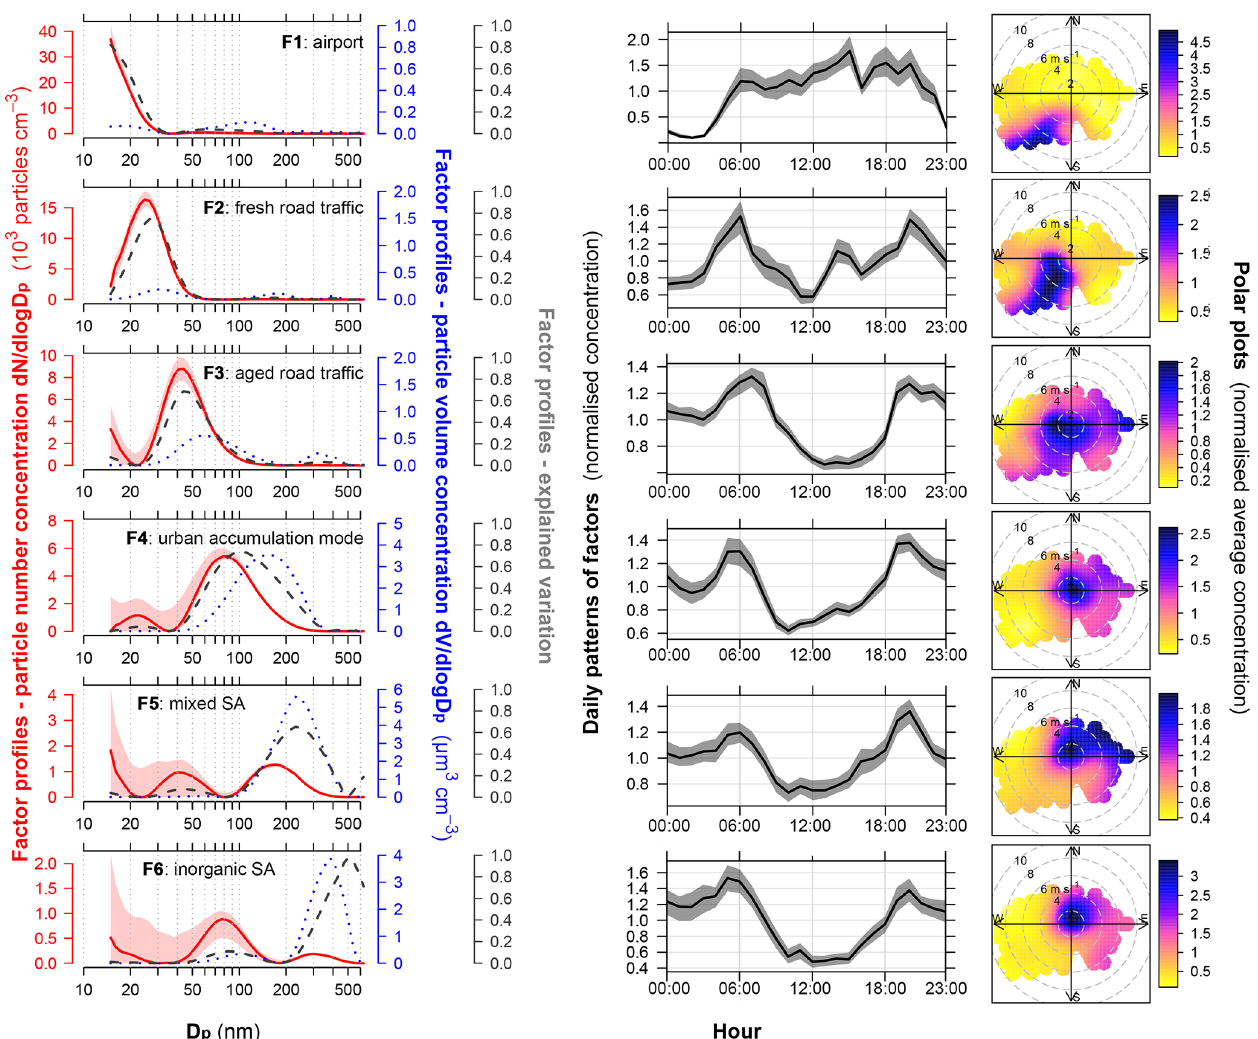
Figure 5. Results of PMF analysis for the warm season data. Factor profiles are reported on the left as (i) number concentration in solid red lines; (ii) their DISP ranges in shaded red areas, (iii) volume concentrations in dotted blue lines; (iv) explained variation in dashed grey lines. The plots in the centre report the normalised daily patterns calculated on the hourly-averaged factor contributions along with their 95th confidence intervals ( n = 200 bootstrap). The plots on the right show the polar plot analysis (normalised average factor contributions). SA: secondary